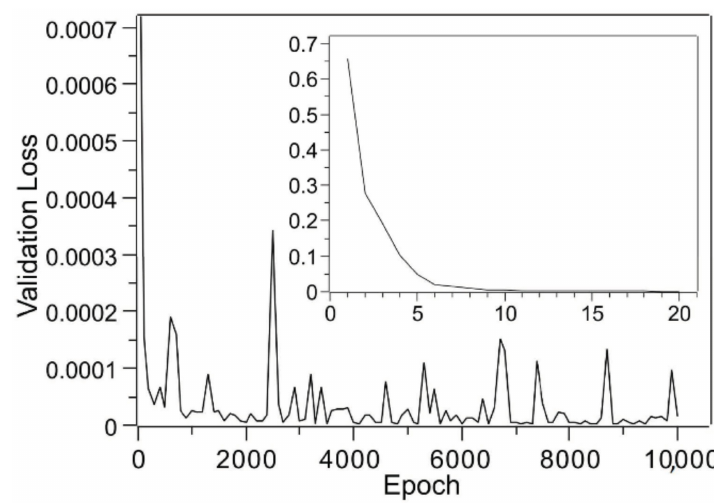
Figure 3. Changes in validation loss with respect to epochs based on training using both two-layer compression data (Table 1) and three-layer compression data (Table 3). The results for the first 20 epochs are displayed as an